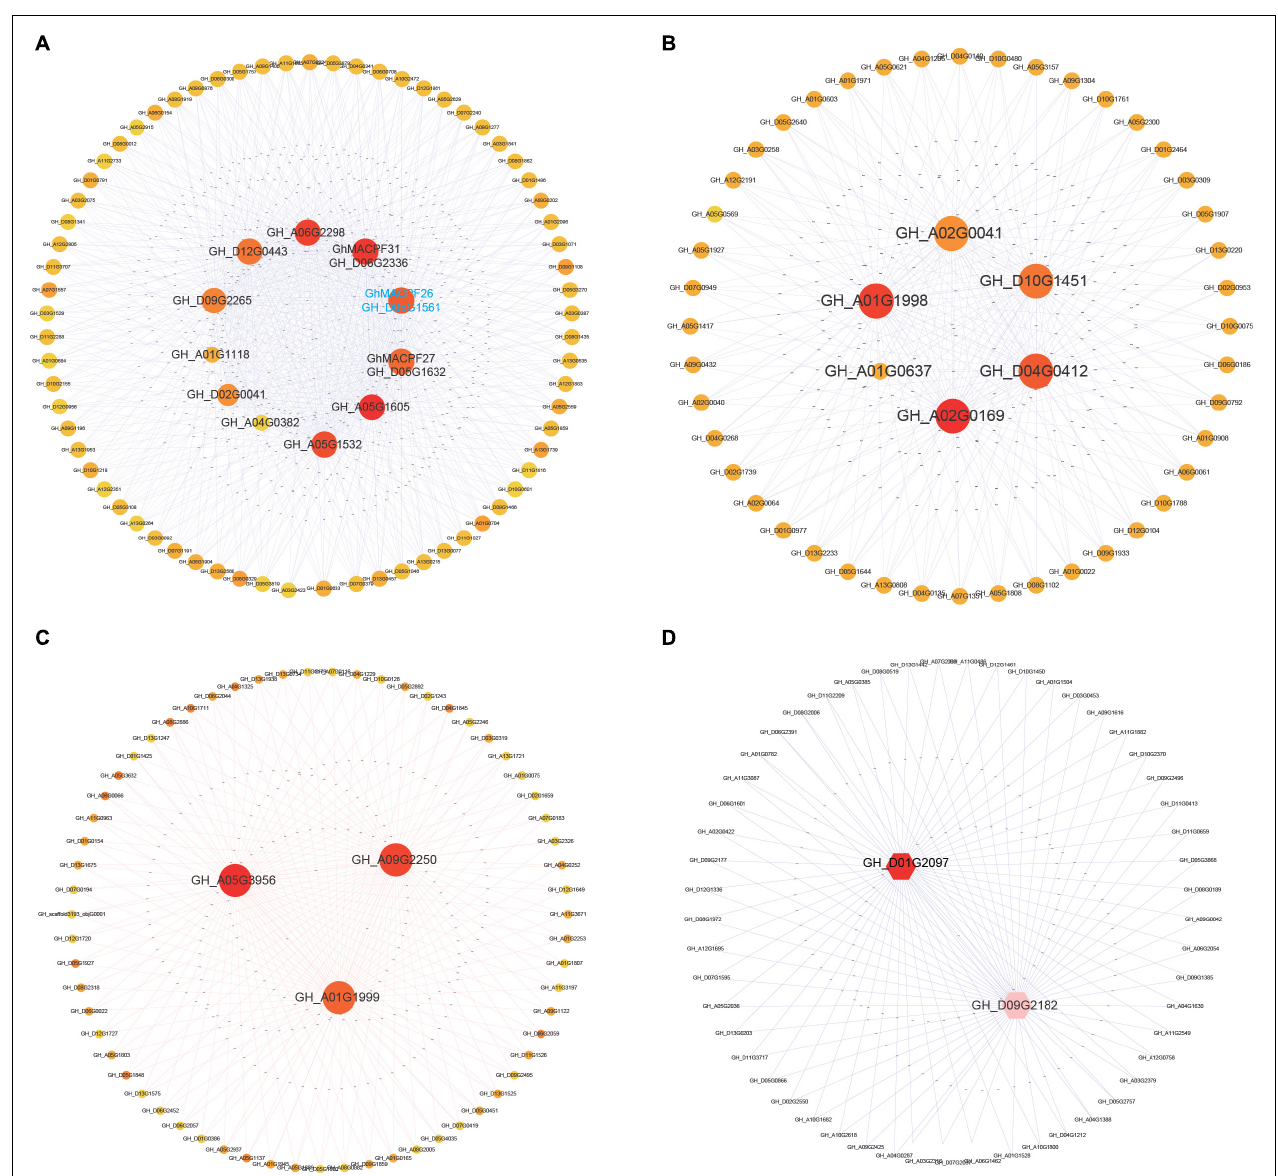
FIGURE 6 | The correlation network of 19 GhMACPF members in cold stresses. All the gene networks are constructed by the weighted gene co-expression network analysis (WGCNA) in which each node represents a gene. (A) (nine GhMACPFs ), (B) (five GhMACPFs ), (C) (three GhMACPFs ), and (D) (two GhMACPFs ) indicate GhMACPFs in the different